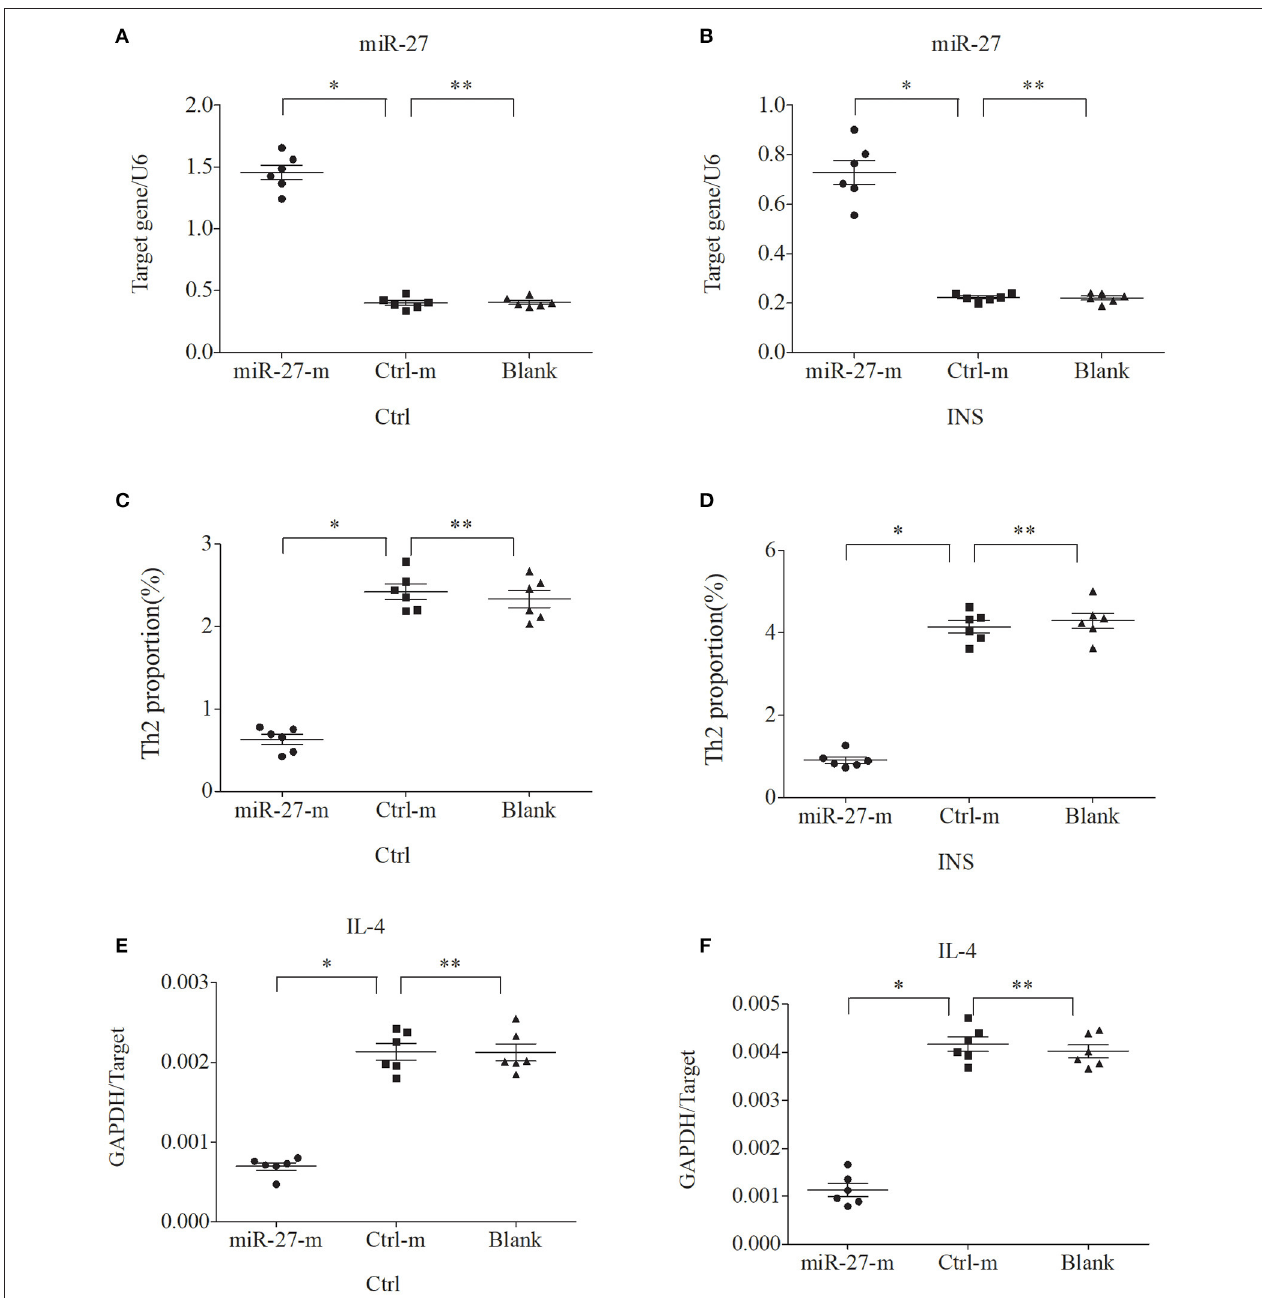
FIGURE 5 | Up-regulation of miR-27 in PBMCs from controls and INS patients (A,B) reduces the percentage of Th2 cells (C,D) and the expression of IL-4 mRNA (E,F) . * P < 0.05 and ** P >